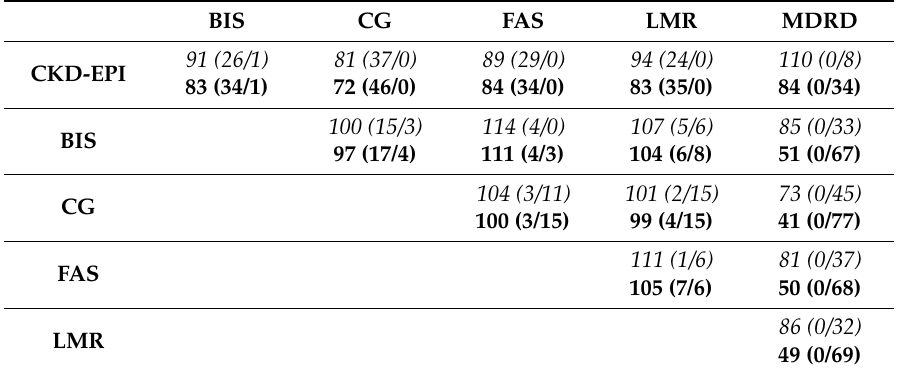
Table 5. The agreement of simulated recommended doses of ibuprofen, morphine, and gabapentin among the six different creatinine-based eGFR equations in relative values (n = 118). Number of patients with agreement in dosage (number of patients where y doses higher than x/number of patients where y doses lower than x). Ibuprofen is marked with cursive font. Morphine and gabapentin are marked with bold font. BIS CG FAS LMR MDRD 91 CKD-EPI